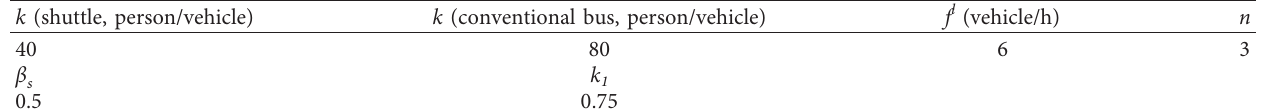
Table 4: Parameter values.